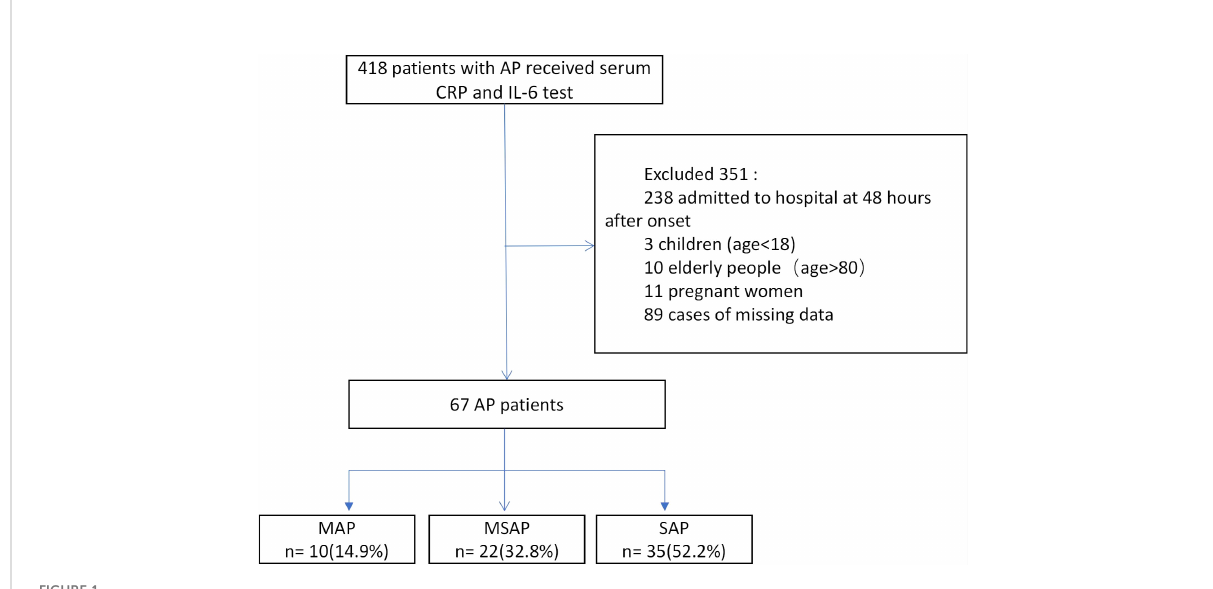
FIGURE 1 Study fl